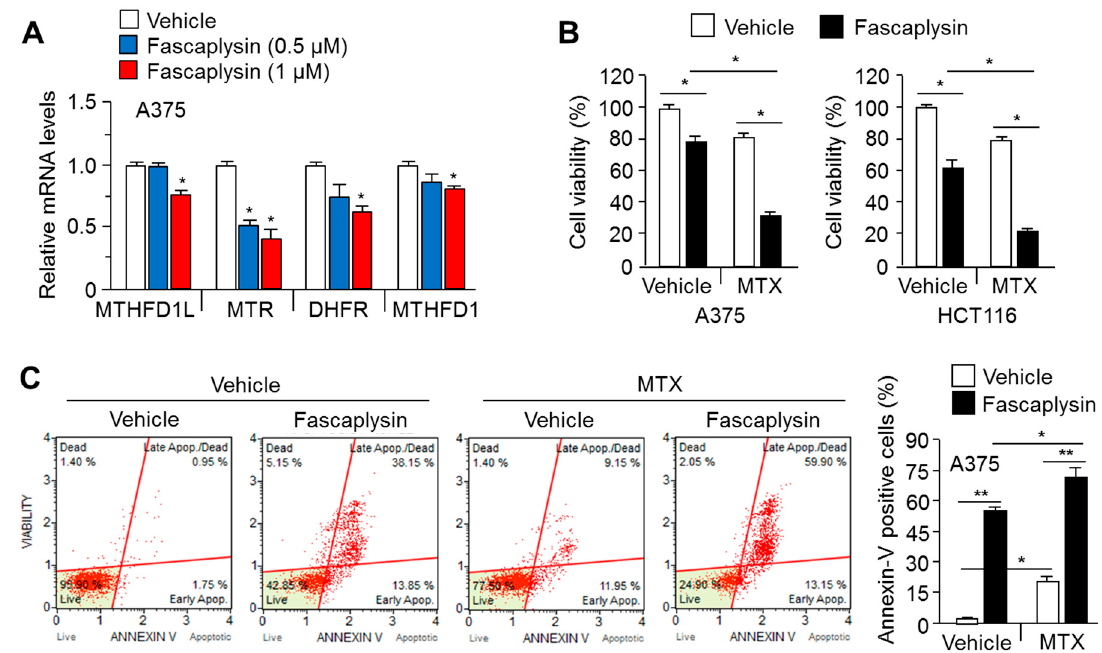
Figure 5. Anti-folate cancer therapy by methotrexate (MTX) enhances the anti-cancer effect of fascaplysin. ( A ) A375 cells were incubated with the indicated concentrations of fascaplysin or DMSO control for 24 h, and then mRNA levels were measured using quantitative real time (RT)-PCR. Values are represented as the mean ± standard deviation (SD) of three independent experiments performed in duplicate; * p < 0.05; ( B ) A375 and HCT116 cells were pre-incubated with 0.1 µ M of MTX for 10 min, and were then further treated with 0.5 µ M of fascaplysin or DMSO control for 24 h. Cell viability was measured using a crystal violet staining assay. Values are represented as the mean ± standard deviation (SD) of three independent experiments performed in triplicate; * p < 0.05; ( C ) A375 cells were pre-treated with 0.1 µ M of MTX for 10 min, and were then further incubated with fascaplysin (0.5 µ M) or DMSO control for 24 h. The apoptotic cell numbers were then measured: values are represented as the mean ± standard deviation (SD) of three independent experiments performed in duplicate; * p < 0.05 and ** p < 0.01.